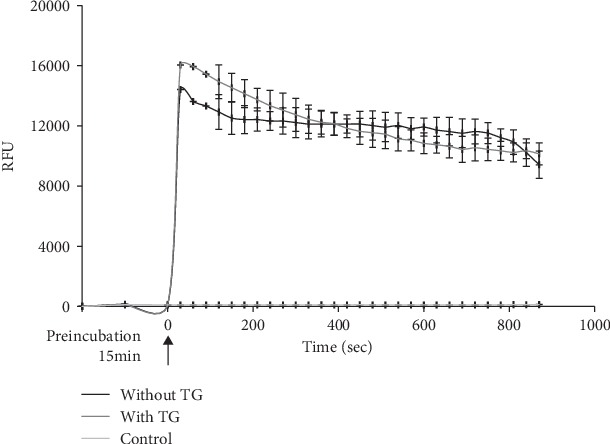
Role of SERCA in compound 4-induced [Ca2+]i increase. Changes in [Ca2+]i were monitored after pretreatment with thapsigargin (TG), followed by addition of 100 μM compound 4 in Ca2+-free medium. Typical [Ca2+]i response to compound 4 after pretreatment of cells with vehicle (black) or with 5 μM thapsigargin (grey) for 15 min. Arrow indicates the time of compound 4 addition. Control is Fura-4 NW loaded cells without stimulator. Values were presented in RFU (relative fluorescence units) ± SD.